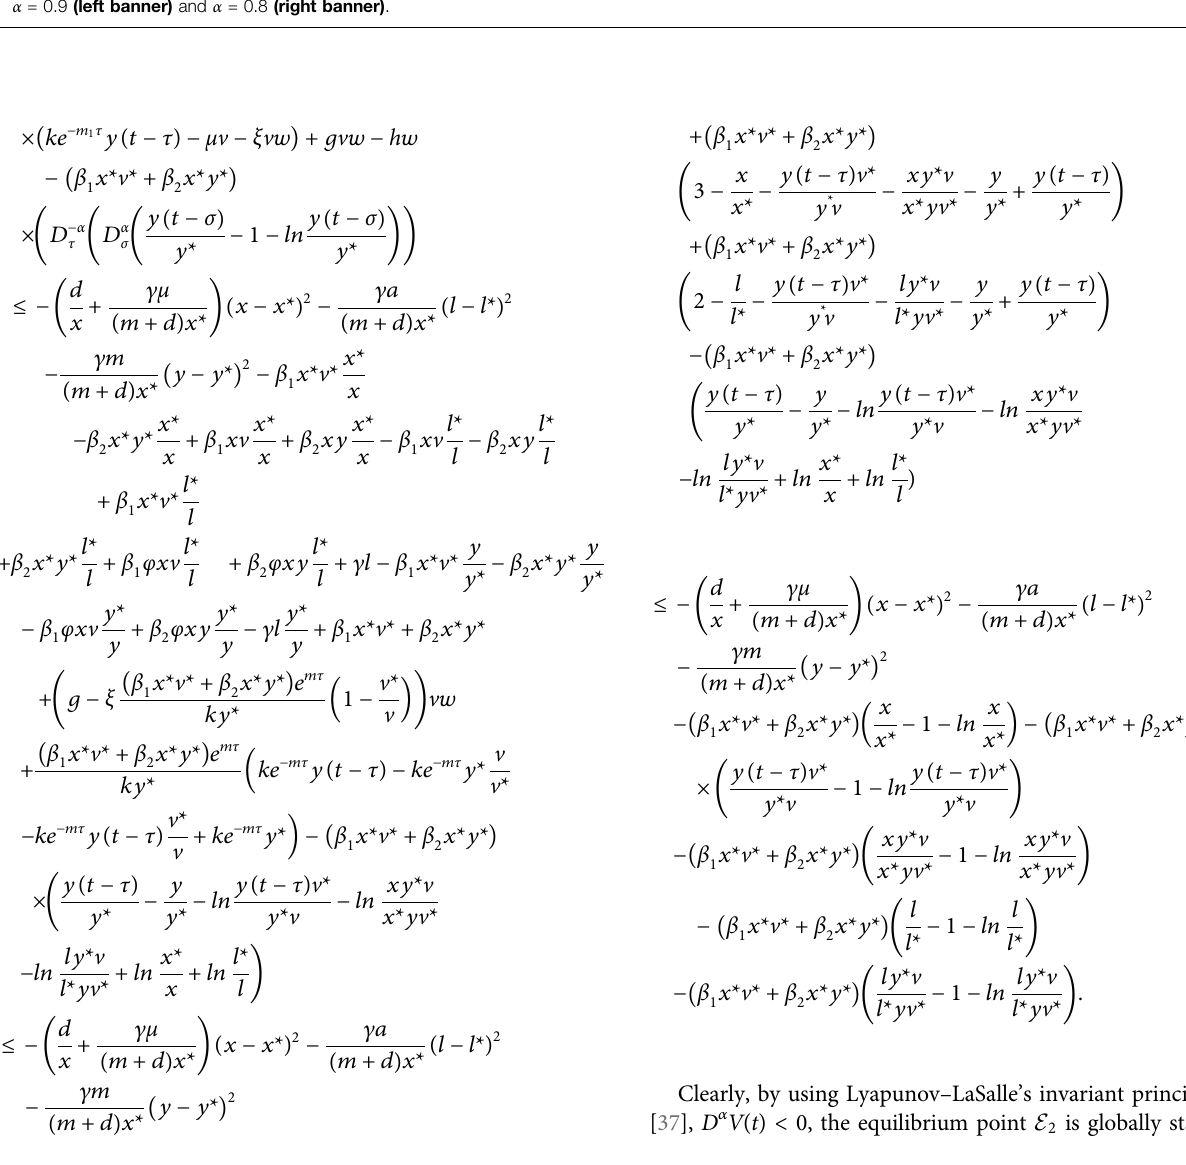
FIGURE 4 | Time trajectories for uninfected cells x ( t ), latently infected cells l ( t ), infected cells y ( t ), viruses v ( t ), and antibodies w ( t ) of Eq. 2 with τ (cid:2) 13 < τ * (cid:2) 13.5, α (cid:2) 0.9 (left banner) and α (cid:2) 0.8 (right banner) .